Question: Write a caption explaining this figure to a reader.
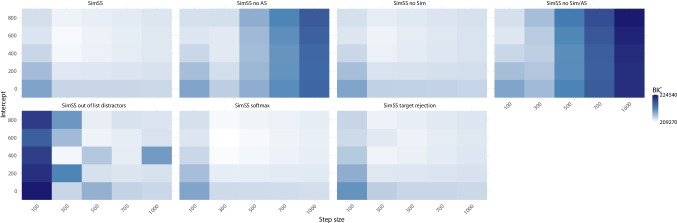
Answer: Shown are the BIC values of the fitted models across various stepsizes and intercepts. We used this coarse grid search to determine the best stepsize and intercept for each model